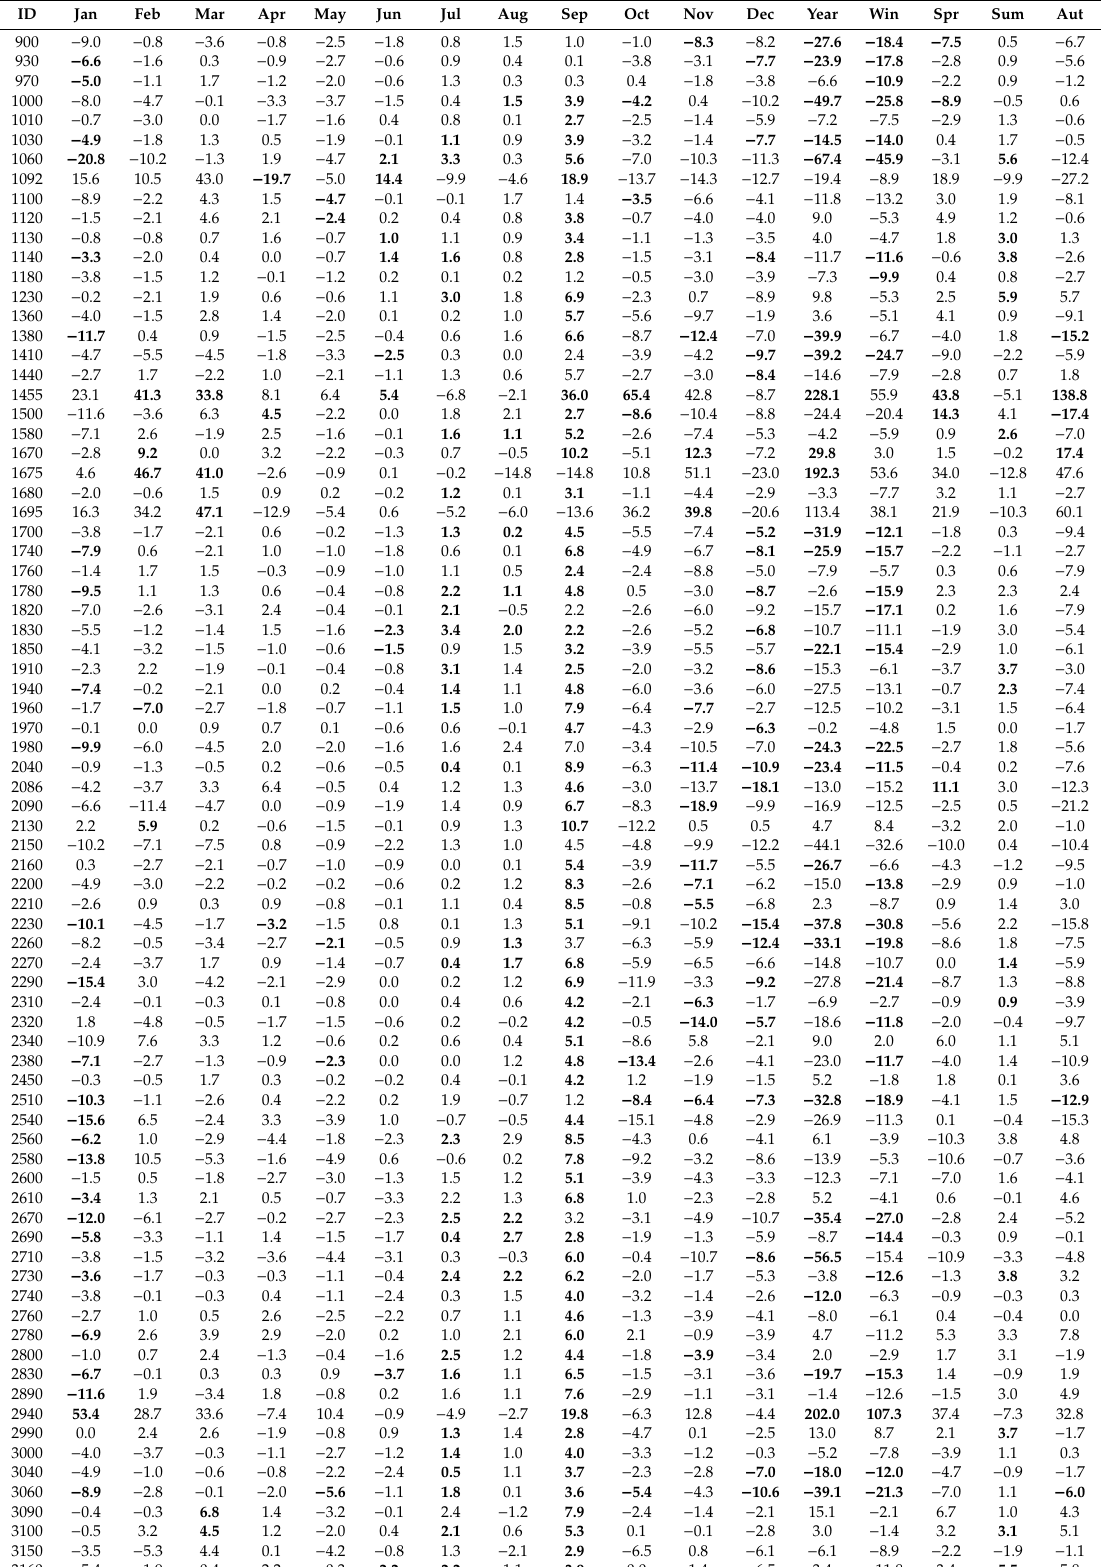
Table 2. Trend slopes (mm / 10 years) evaluated with the linear regression. Bold values identify significant